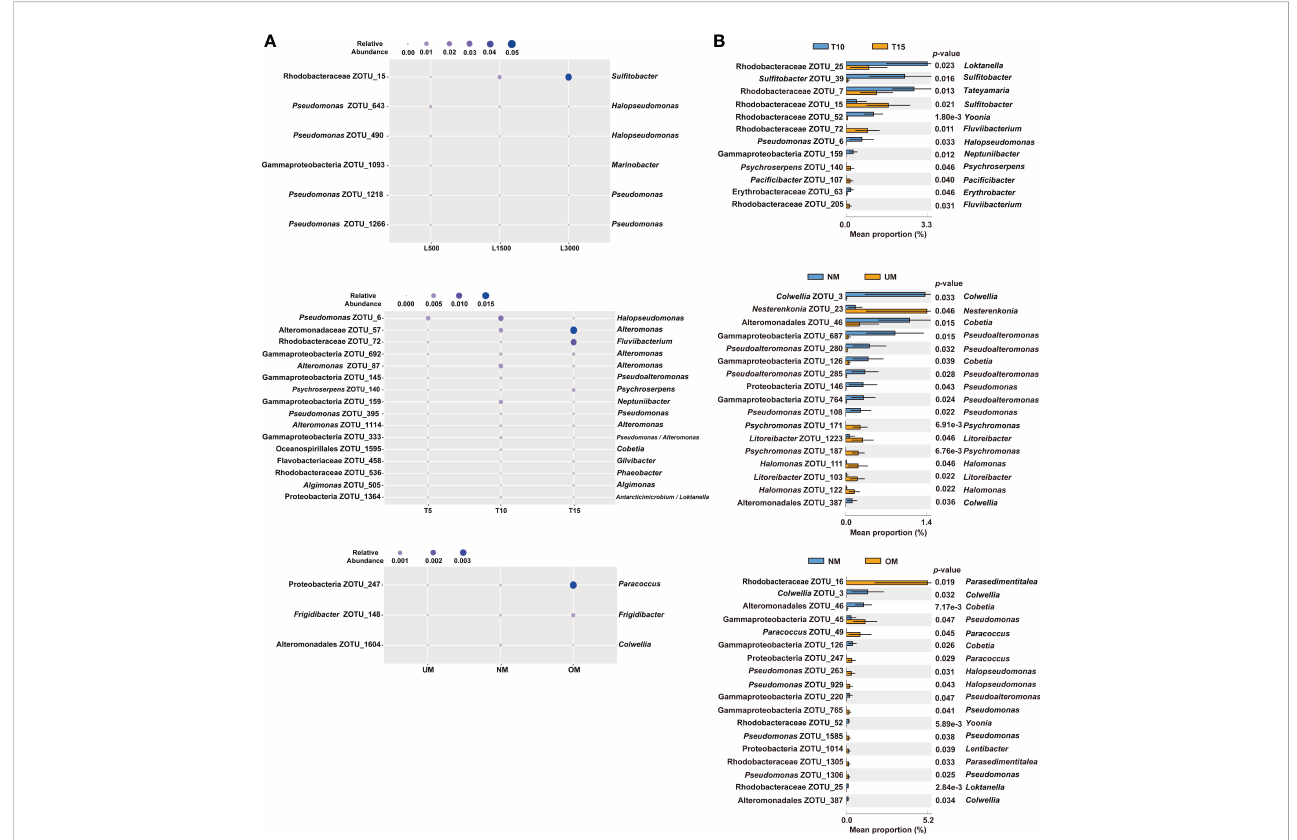
FIGURE 4 Signi fi cantly different epiphytic bacterial ZOTUs among treatment groups (A) and between groups with different MD severity (B) . For (A) , signi fi cant differences were determined using RF and ANOVA ( p < 0.05, Tukey post-hoc test); for (B) , signi fi cant differences were determined using Welch ’ s t -test (effect size >0.1, p < 0.05). Taxonomic information on the right of all the plots is determined using BLAST.